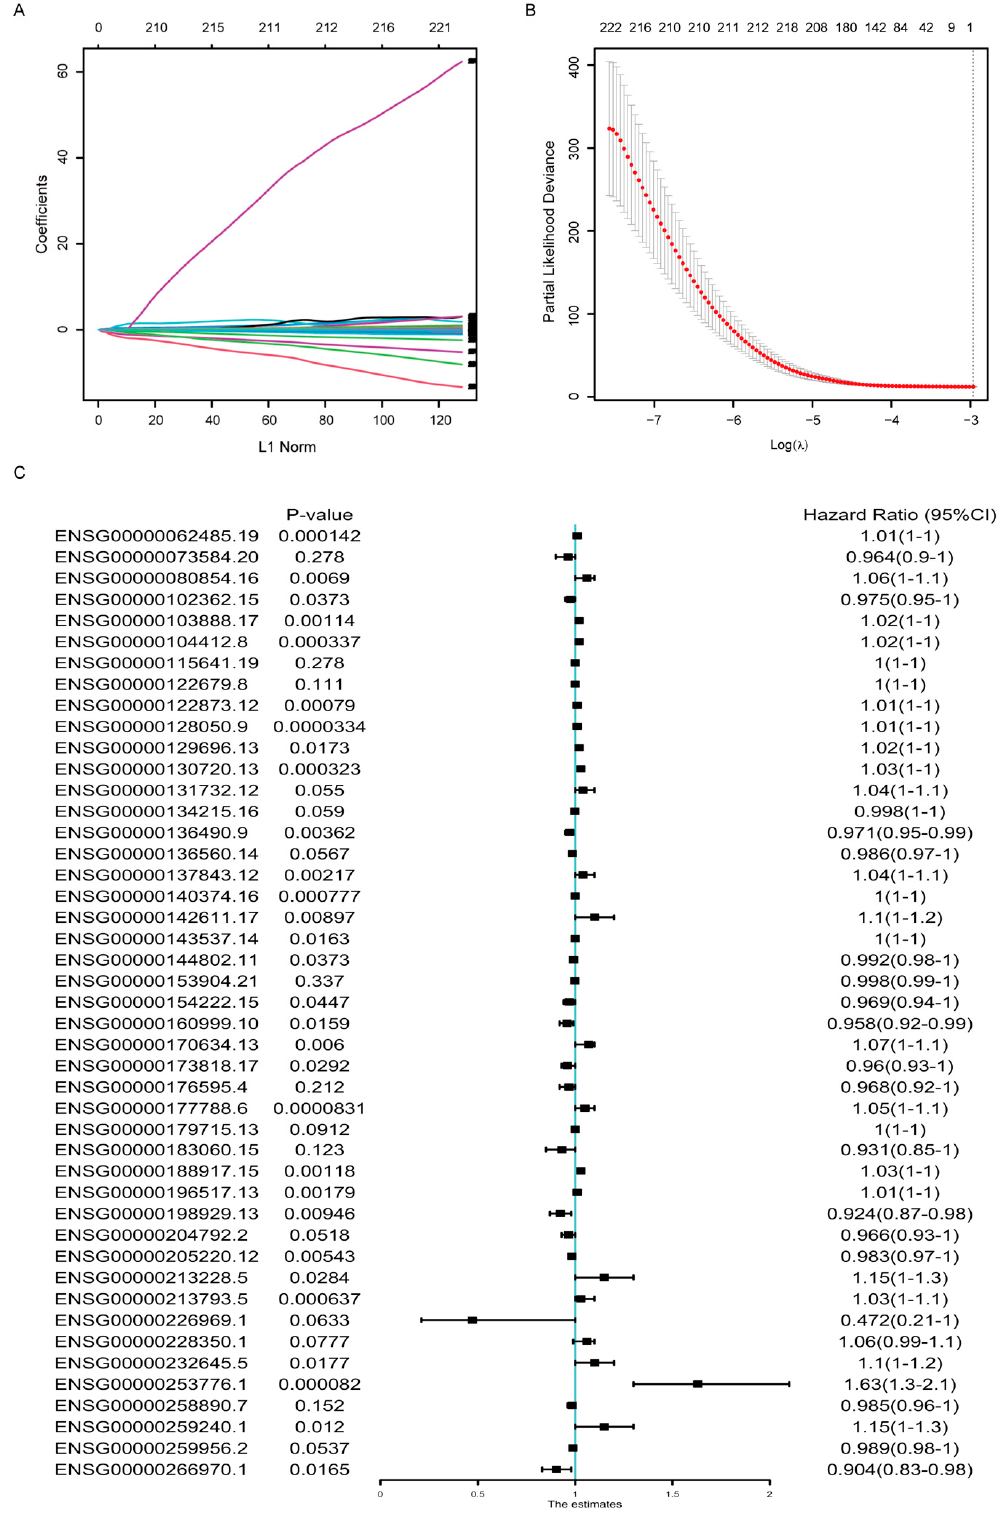
Figure 2. Development of the gene signature based on data in the TCGA-BRCA training cohort. ( A ) LASSO coefficient profiles of the DEGs. ( B ) Ten-time cross-validation for tuning parameter screening in the Lasso–Cox penalized regression model. ( C ) Univariate Cox regression analysis of the relation between the expression of the 45 signature genes and the overall survival in the TCGA-BRCA cohorts. HR, hazard ratio; CI, confidence